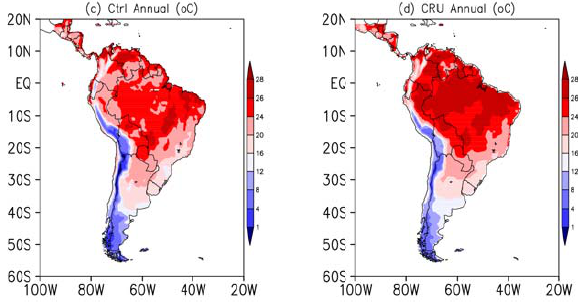
Figure 2. Annual mean (1980–2009) of precipitation (mm day − 1 ) from: ( a ) CTRL experiment and ( b ) CRU. Annual mean (1980–2009) of temperature ( ◦ C) from: ( c ) CTRL experiment and ( d ) CRU.